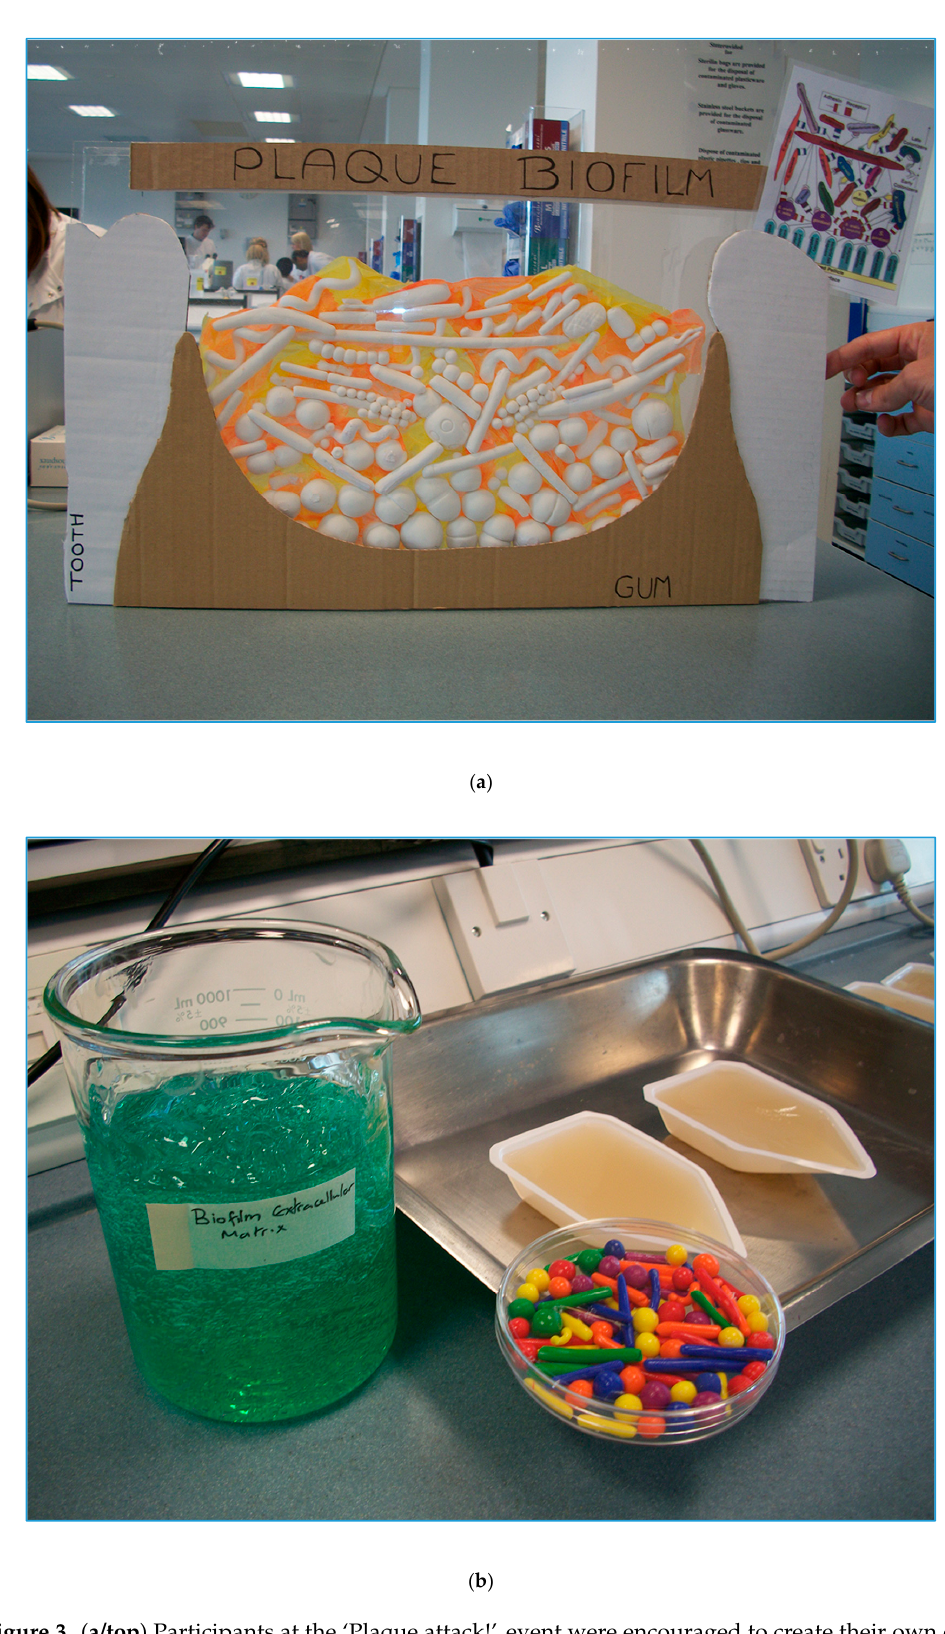
Figure 3. ( a / top ) Participants at the ‘Plaque attack!’ event were encouraged to create their own oral bacteria flora from modelling clay, which was assembled into the oral biofilm representation here shown. ( b / bottom ) Participants were encouraged to ‘destroy a biofilm’ by removing bacteria (coloured plastic pieces) encased in biofilm extracellular matrix (hair gel) with a spray bottle filled with